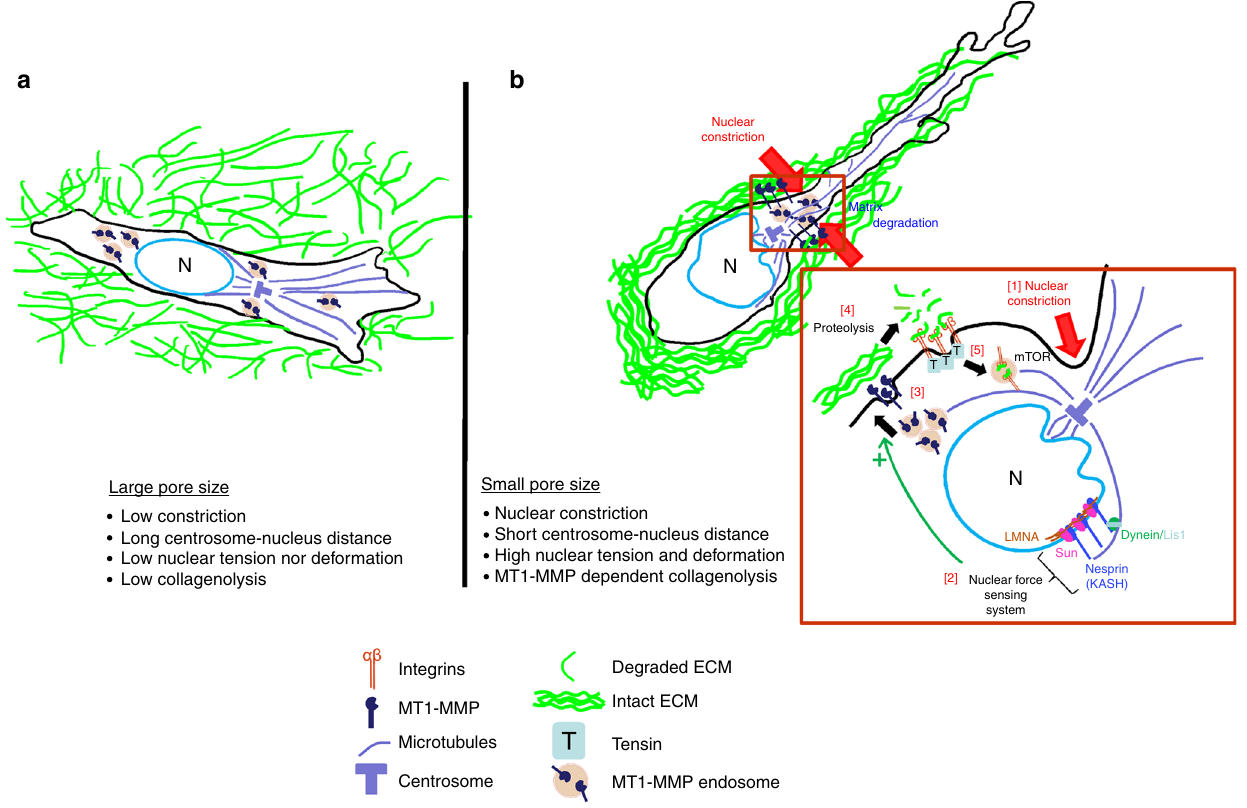
Fig. 1 Nuclear constriction triggers delivery of vesicular MT1-MMP to the plasma membrane. a When cells invade through extracellular matrices (ECM) with large pores (pore size greater than the nucleus), there are few physical constraints on the nucleus and the centrosome – nucleus axis is not under tension resulting in a longer centrosome – nucleus distance. Low nuclear tension or little deformation are observed and the MT1-MMP delivery system is not triggered, as there is no need for collagenolysis to relieve physical constriction. b Cells invading into denser ECM, with pore size smaller than the nucleus, face a physical barrier to their movement. The matrix imposes a nuclear constriction [1] in the cell moving forward and creates nuclear tension that is sensed via the centrosome – nucleus linkage [2] which becomes stronger as evidenced by reduced centrosome – nucleus distance. This leads to the recruitment of intracellular MT1-MMP, stored in late endosomes, that then traf fi c to the site of physical constriction [3] on the plasma membrane. MT1- MMP then mediates ECM degradation to relieve the tension and make space for the nucleus to go through [4]. Integrins, also present in the same region of the plasma membrane, may then mediate uptake of the degraded matrix, in a tensin-dependent fashion. Degraded ECM then traf fi cs to the late endosomes where it can support mTOR activation, a metabolic sensor [5]. Thus, focussed proteolysis at the points of nuclear constriction followed by ECM uptake through ligand-bound integrin internalisation may help cancer cells to scavenge nutrients to maintain energy